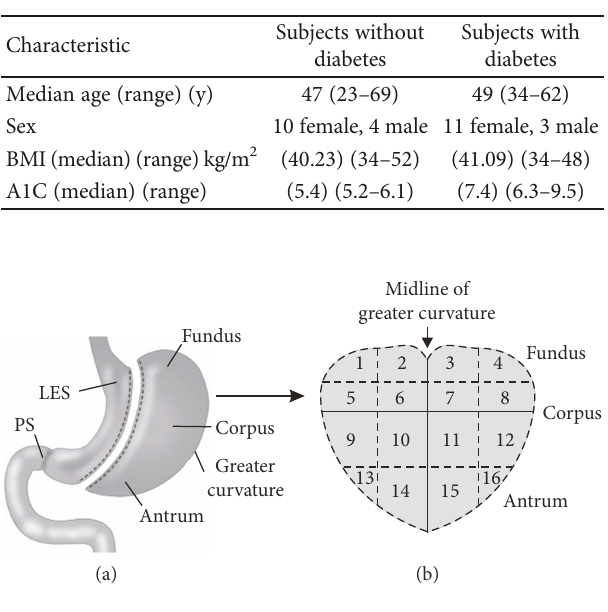
Figure 1: Diagram and map of anatomical regions of the resected stomach from vertical sleeve gastrectomy. (a) Sketch of the anatomical regions of the resected stomach from a typical vertical sleeve gastrectomy. (b) Schematic map used to demarcate the corresponding anatomical regions of the resected stomach when laid out fl